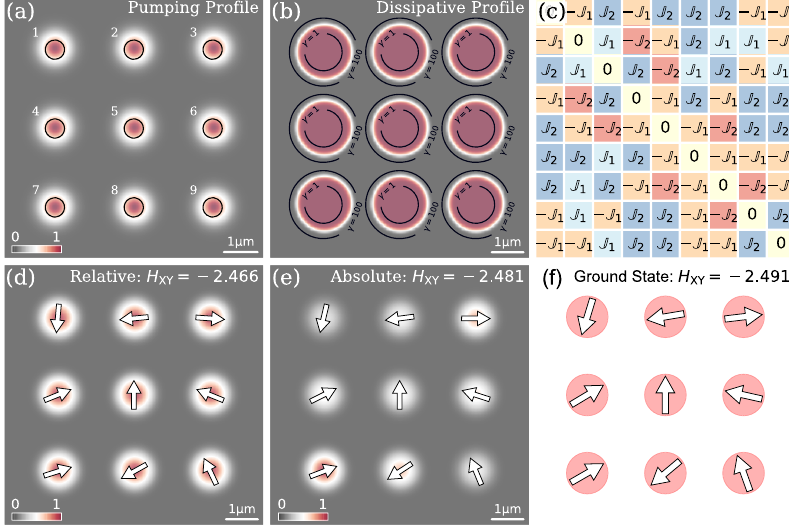
Figure 2: Finding the global minimum of the XY Hamiltonian of size N (cid:1) 9 with a 3 × 3 polariton lattice by simulating Eqs. (7) and (8). (a) The intensity distribution of the incoherent pumping pro fi le P ( r ) . The condensate emissions within the black circles are used for couplings between condensates. (b) The dissipative pro fi le for realisingspatiallyisolatedpolaritonpillars. (c) The fully-connected coupling matrix J which is randomly constructed from J 1 (cid:1) 0 . 05and J 2 (cid:1) 0 . 1ofrandomsigns.(d – e) The polariton density pro fi les and phase con fi gurations are plotted for relative and absolute coupling models, respectively. The white arrows represent the phase difference with respect to the central condensate (with respect to the vertical arrow). The corresponding energy values of the XY Hamiltonian are shown in the top- right corner. (f) The ground state solution